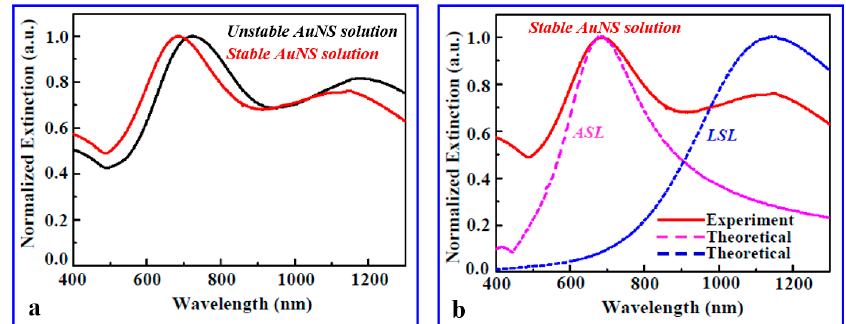
Figure 2. ( a ) The UV-Vis-NIR spectra of the synthesized AuNS solution in both stable and unstable condition. ( b ) Normalized experimental extinction cross section of stabilized AuNS solution and the relevant theoretical investigation of the extinction property of AuNSs with two different spike lengths. The largest spike length (LSL) and average spike length (ASL) were calculated based on the collected TEM information.